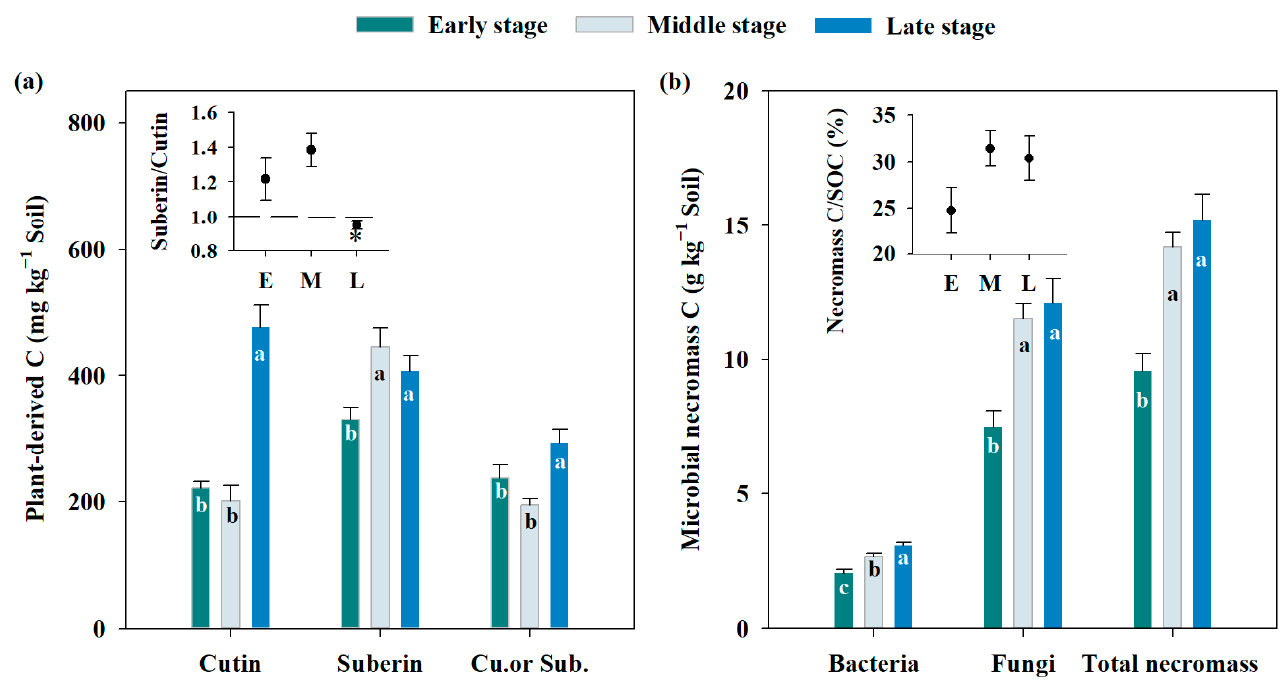
Figure 2. Cutin and suberin (panel ( a )) and microbial necromass C concentrations (panel ( b )) in the top 20 cm of soils at three successional stages. Note: E = early-successional stage, M = mid-successional stage, and L = late-successional stage. Suberin/Cutin = ( ∑ Suberin + ∑ Cu. or Sub.)/( ∑ Cutin + ∑ Cu. or Sub.). Cu. or Sub. represents the unidentified components originated from suberin or cutin. Different lowercase letters indicate significant differences among successional stages, p < 0.05. The asterisks (*) in the insets also signify significant differences, p < 0.05. Dots and bar charts represent mean values, vertical bars represent the standard error.